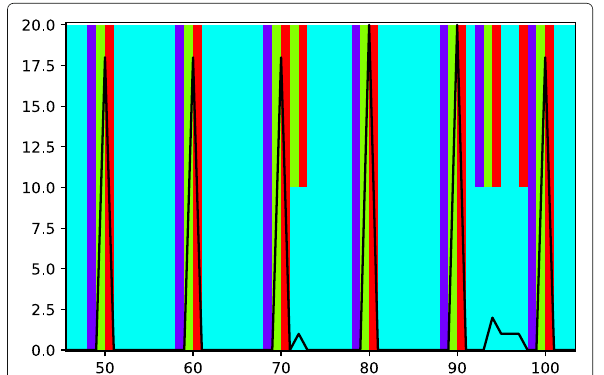
Fig. 8 Classifier with n 0 = 10, n n 0 = 10 applied to wave with pulse anomaly injected at time stamp